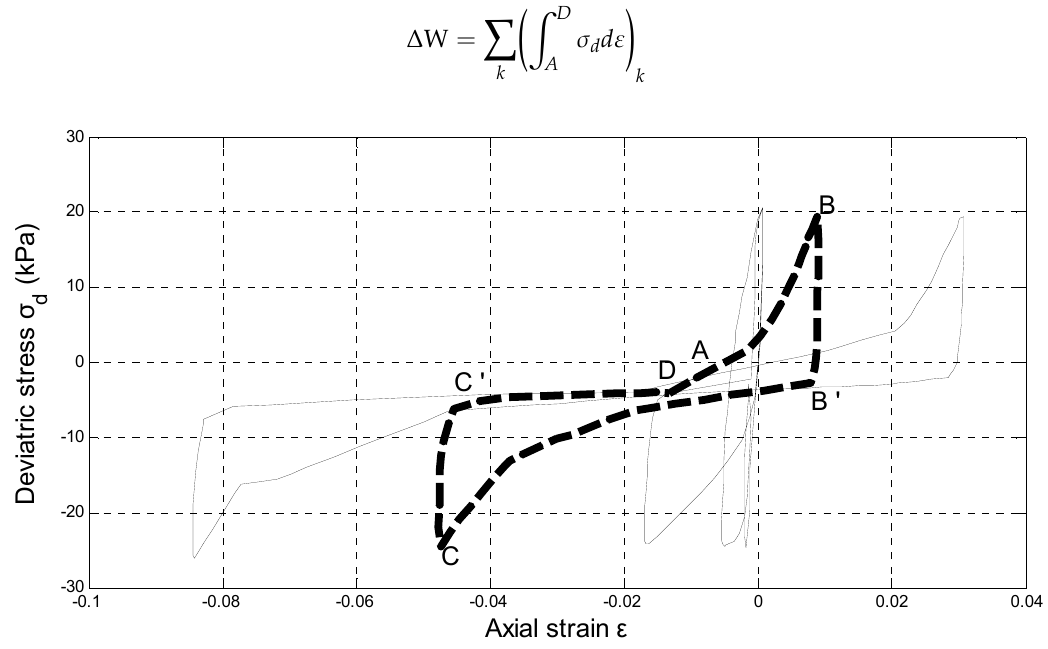
Figure 1. Typical stress–strain relationship during undrained cyclic triaxial test [18].